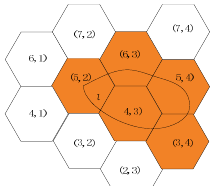
Figure 8. Indivisible area mapping results in the model